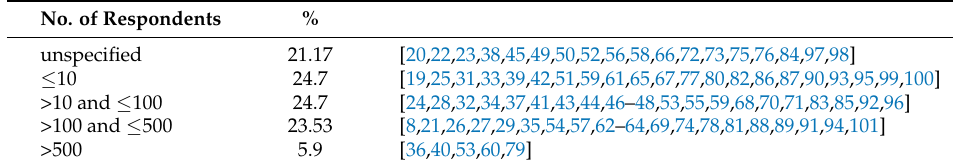
Table 4. Distribution of paper by number of respondents.